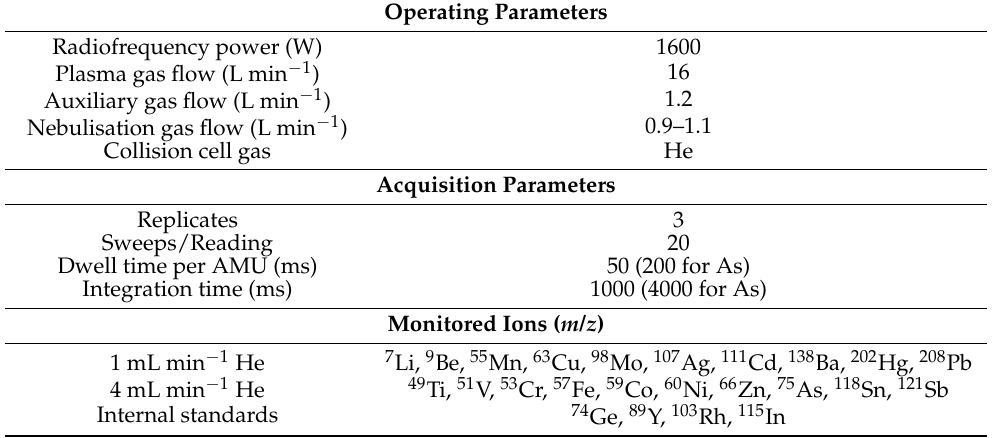
Table 3. ICP-MS conditions for metal assessment in digested clothing